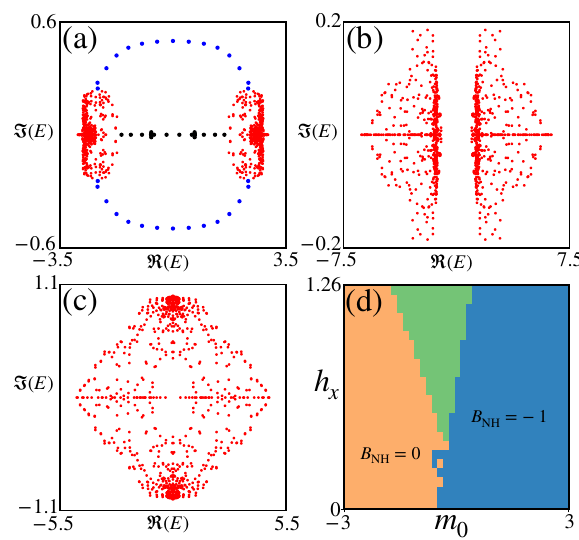
Fig. 3 Energy spectra and phase diagram on non-Hermitian (NH) Sierpinski carpet fractal. The energy spectra of H FO [Eq. (1)] for t = t 0 = 1, r 0 = a , R = 2 a , and a m 0 = 2.0 and h x = 0.5, b m 0 = − 2.0 and h x = 0.4 and c m 0 = − 0.5 and h x = 1.0 with periodic boundary condition (PBC) only in the x direction. The system describes a NH (a) Chern insulator with the NH Bott index B NH = − 1, b trivial insulator with B NH = 0, and c insulator, where B NH is not well de fi ned. In a and b the spectra display line gaps. In c the spectra display a point gap. In a two spectral lobes with ℜ ( E ) < 0 and ℜ ( E ) > 0 are connected via topological modes, localized at top and bottom outer edges (blue dots) and inner edges (black dots). d Phase diagram of H FO in the ( m 0 , h x ) plane hosts these three insulating phases with B NH = − 1 (blue region), B NH = 0 (orange region), and where B NH is not well de fi ned (green region). These outcomes remain qualitatively unchanged when we impose additional PBC in the y direction, except the outer edge modes [blue dots in a ] disappear. See Supplementary Fig. 4.